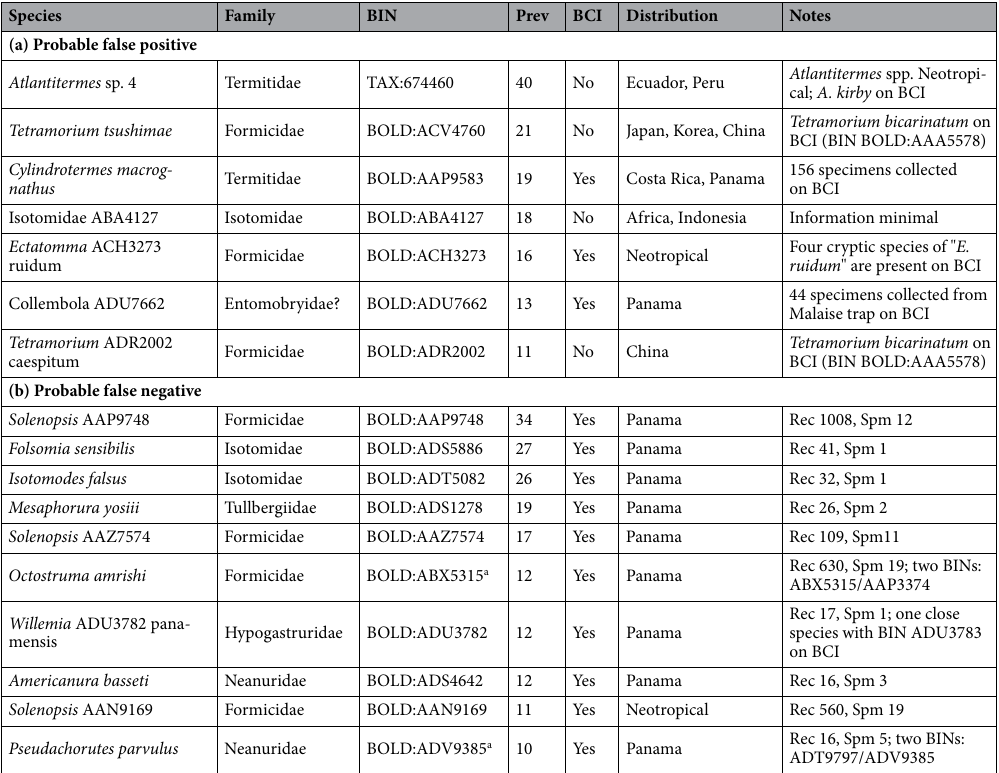
Table 3. List of species considered as "probable false positive" (i.e., high prevalence in metabarcoding samples but absent in traditional samples) and as "probable false negative" (i.e., high prevalence in traditional samples but absent in metabarcoding samples). Prev Prevalence in samples, Rec no. of records on BCI, years 2008–2019, Spm no. of specimens with BINs. Sources: BOLD (https:// www. bolds ystems. org/); Termite catalog (http:// 164. 41. 140.9/ catal/); antwiki (https:// www. antwi ki. org). a See